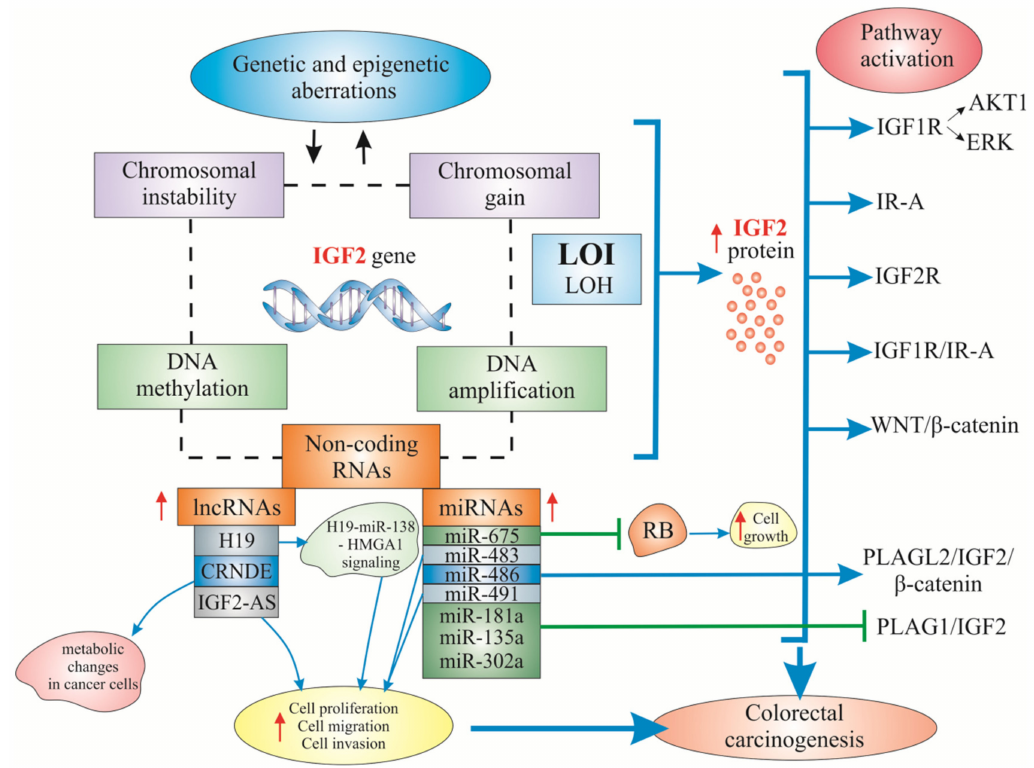
Figure 2. IGF2 gene and protein-associated non-coding RNA-regulatory mechanisms and the best-known IGF2-associated signaling pathways in colorectal carcinogenesis. Legend: ⇓ regulation; ↑ / ↓ increase / decrease; ⊥ :